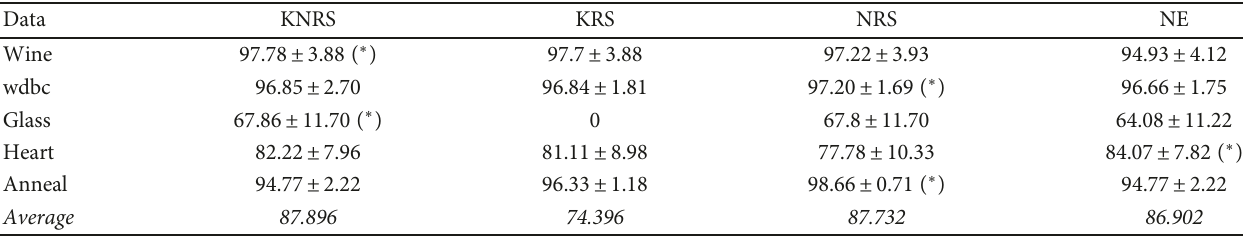
Table 7: Classi fi cation accuracies based on RBF SVM (%).